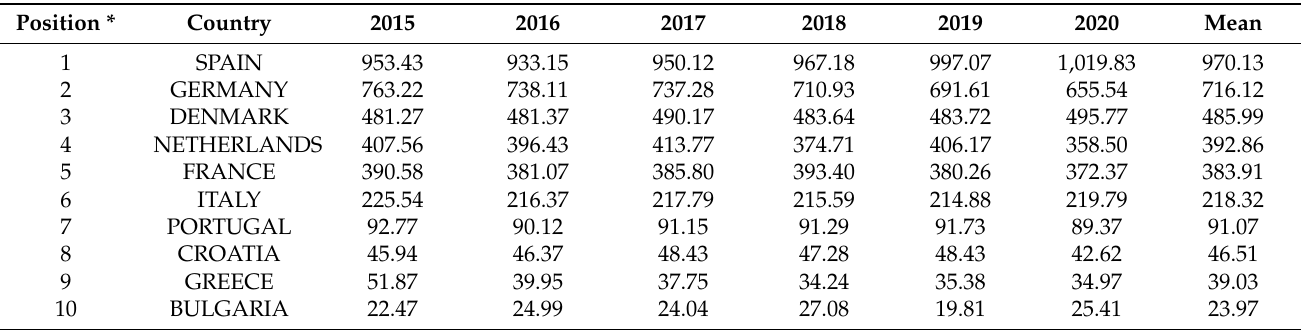
Table 3. Results of CH 4 emissions from enteric fermentation using Tier 1 methodology (Gg CO 2 -